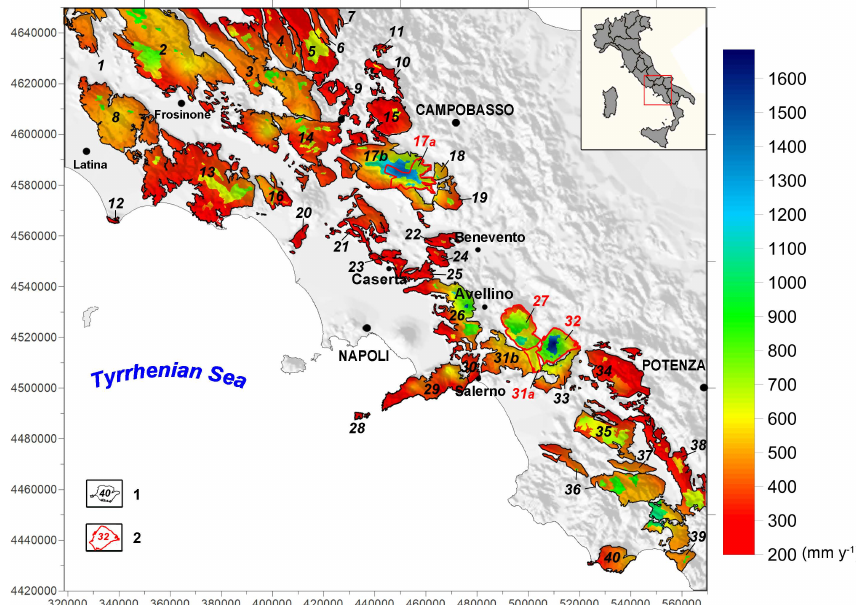
Fig. 8. Distributed model of the mean annual groundwater recharge for karst aquifers of the southern Apennines. Key to symbol: (1) hydro- geological boundaries and identification number of the karst aquifers; (2) hydrogeological boundaries and identification number of the karst aquifers considered for the hydrological budget.